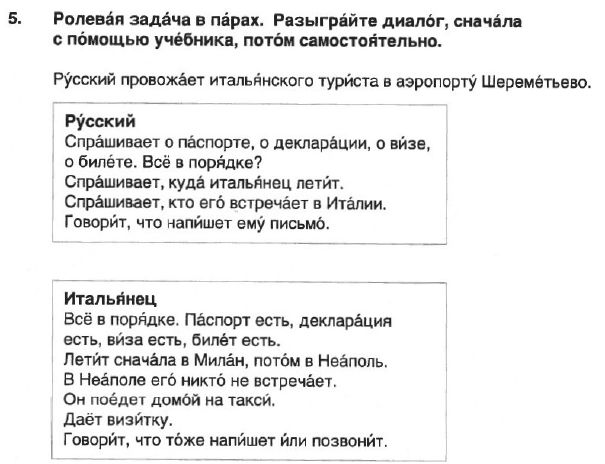
Figure 5. Example 1 of a task in Molodets .